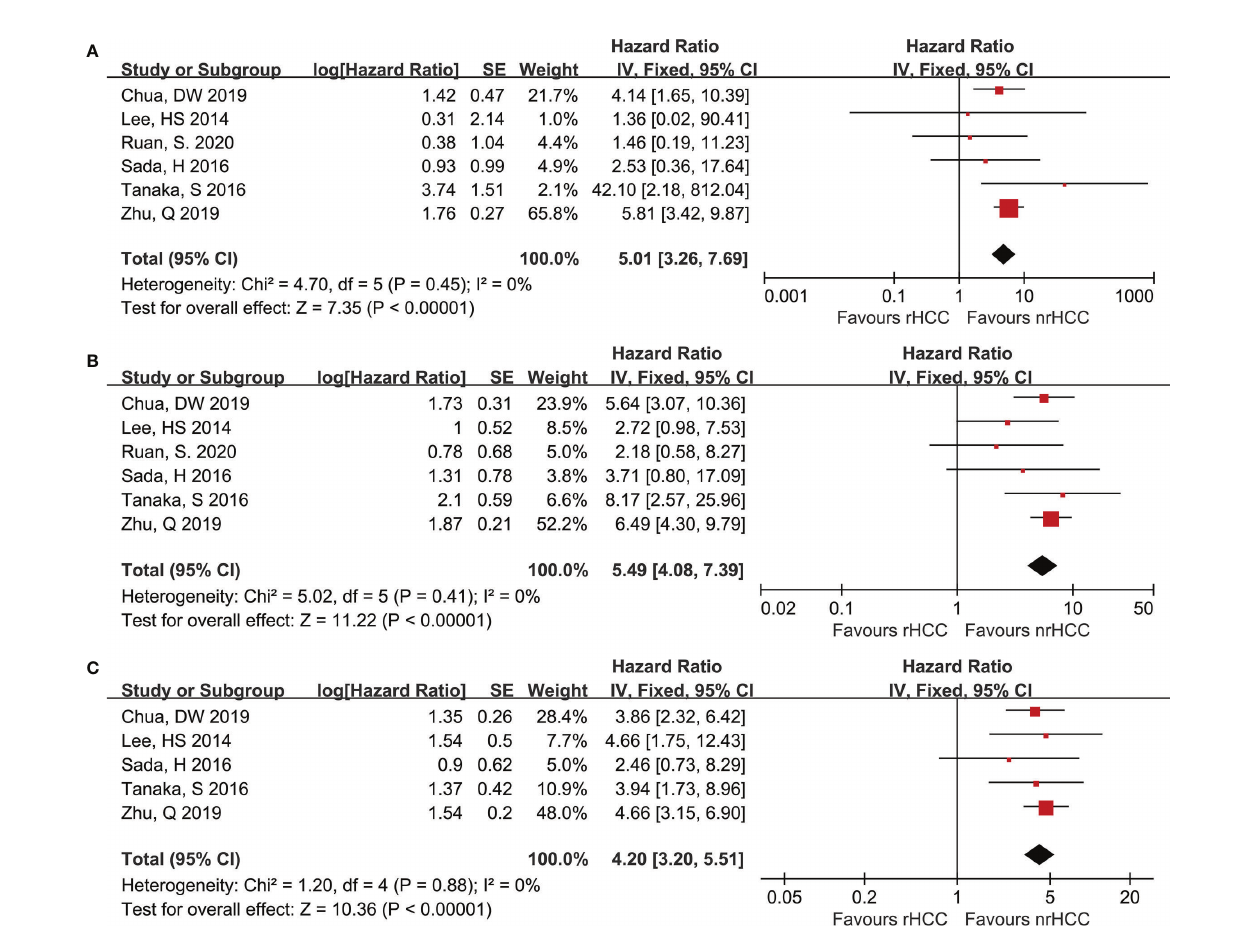
FIGURE 3 | Forest plots for OS. (A) Forest plot for 1-year OS indicates signi fi cantly decreased OS in the rHCC group as compared with that in the nrHCC group (HR, 5.01; 95% CI: 3.26 – 7.69). (B) Forest plot for 3-year OS indicates signi fi cantly decreased OS in the rHCC group (HR, 5.49; 95% CI: 4.08 – 7.39). (C) Forest plot for 5-year OS indicates signi fi cantly decreased OS in the rHCC group (HR, 4.20; 95% CI: 3.20 –